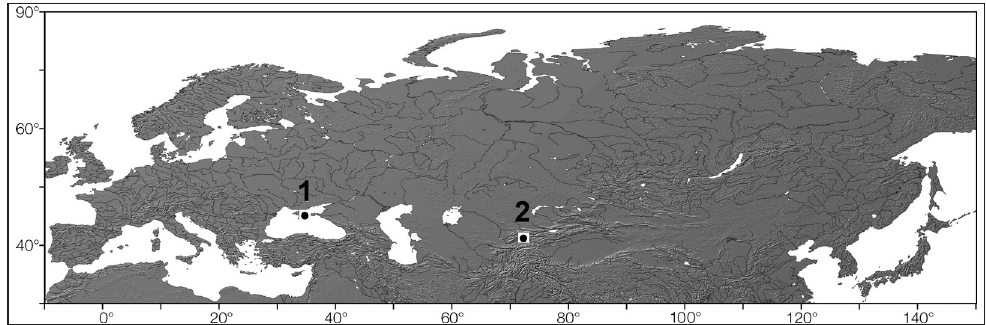
Figure 7. Distribution of Catapterix in the Palaearctic Region. 1. C. crimaea Zaguljaev & Sinev; 2. C. tian- shanica sp.